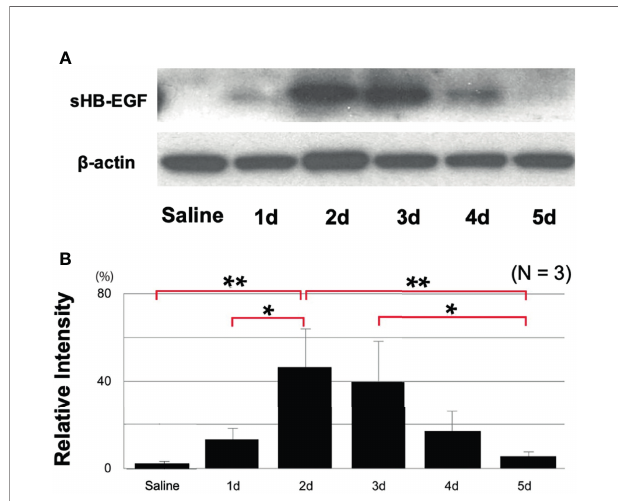
FIGURE 3 | Western blotting demonstrates HB-EGF processing during OM. (A) Representative blots for rat MEs are shown. The processed form, sHB- EGF, was distinguished from proHB-EGF by its lower molecular weight, (B) Relative band intensity quanti fi cation con fi rms that sHB-EGF increases to a maximum 2 days after administration of 500 m g of Poly(I:C), then progressively decreases. Saline control mucosa at 2 days shows a low sHB-EGF level. N refers to number of samples. *p < 0.05, **p < 0.01.